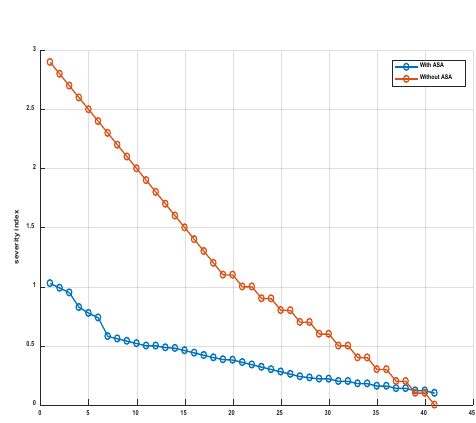
Figure 3. Analysis of Severity index